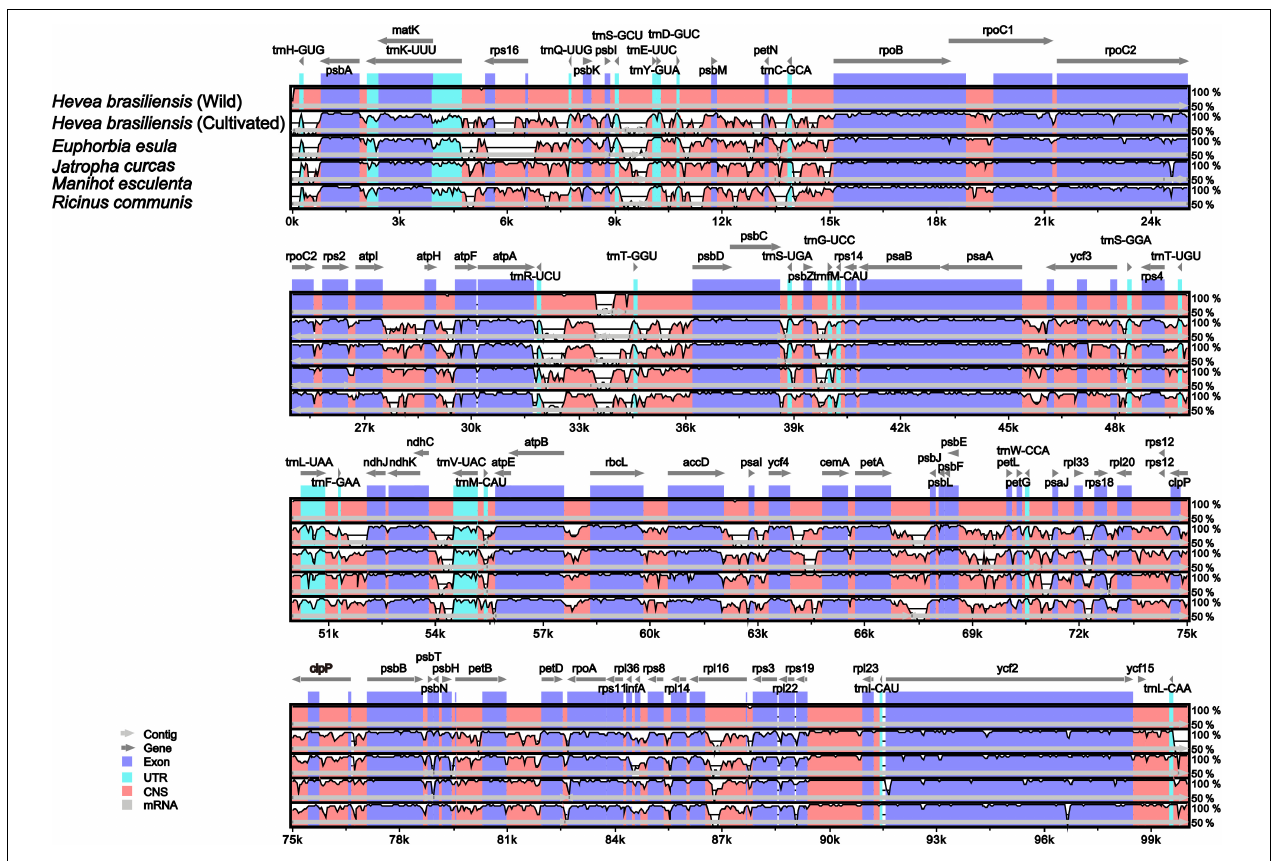
FIGURE 5 | Alignment of the six chloroplast genome sequences. VISTA-based identity plot shows sequence identity among the six Euphorbiaceae species using Hevea brasiliensis cp genome (67) as a reference. The vertical scale designates the percentage of identity, ranging from 50 to 100%. The horizontal axis indicates the coordinates within the chloroplast genome. Genome regions are color-coded as exons, introns, and conserved non-coding sequences (CNS).